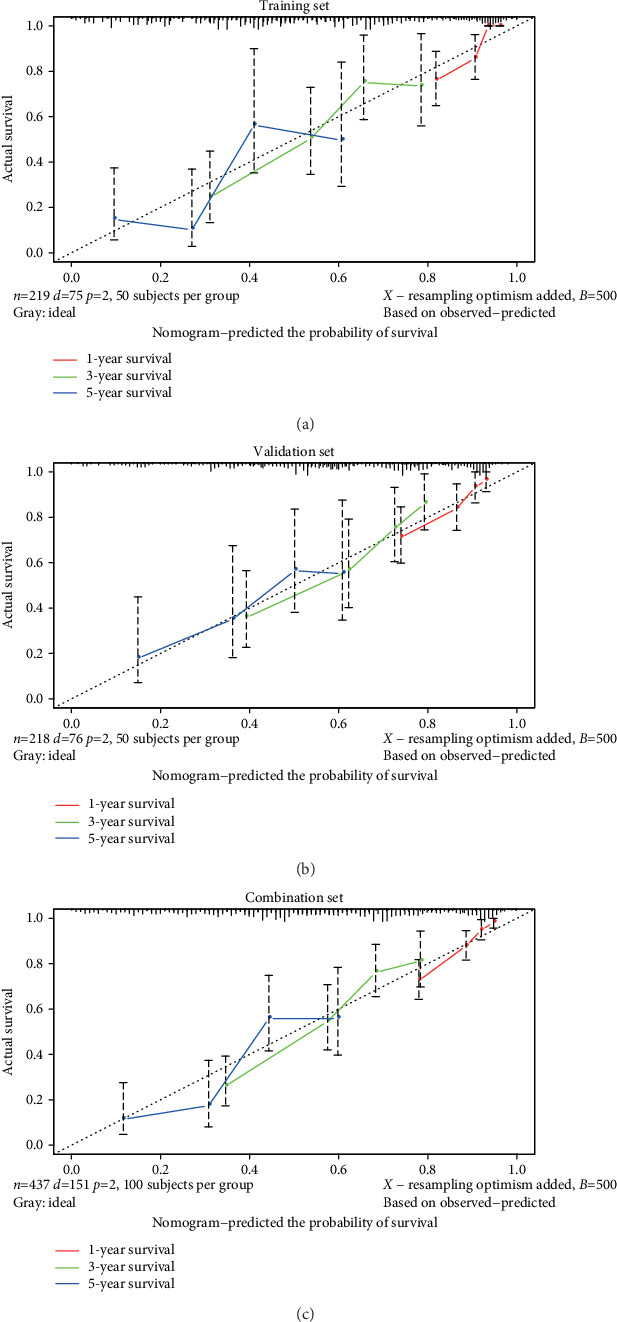
Calibration plots showed that there was good agreement between the actual observations and predictions. (a) Training set. (b) Validation set. (c) Combination set.